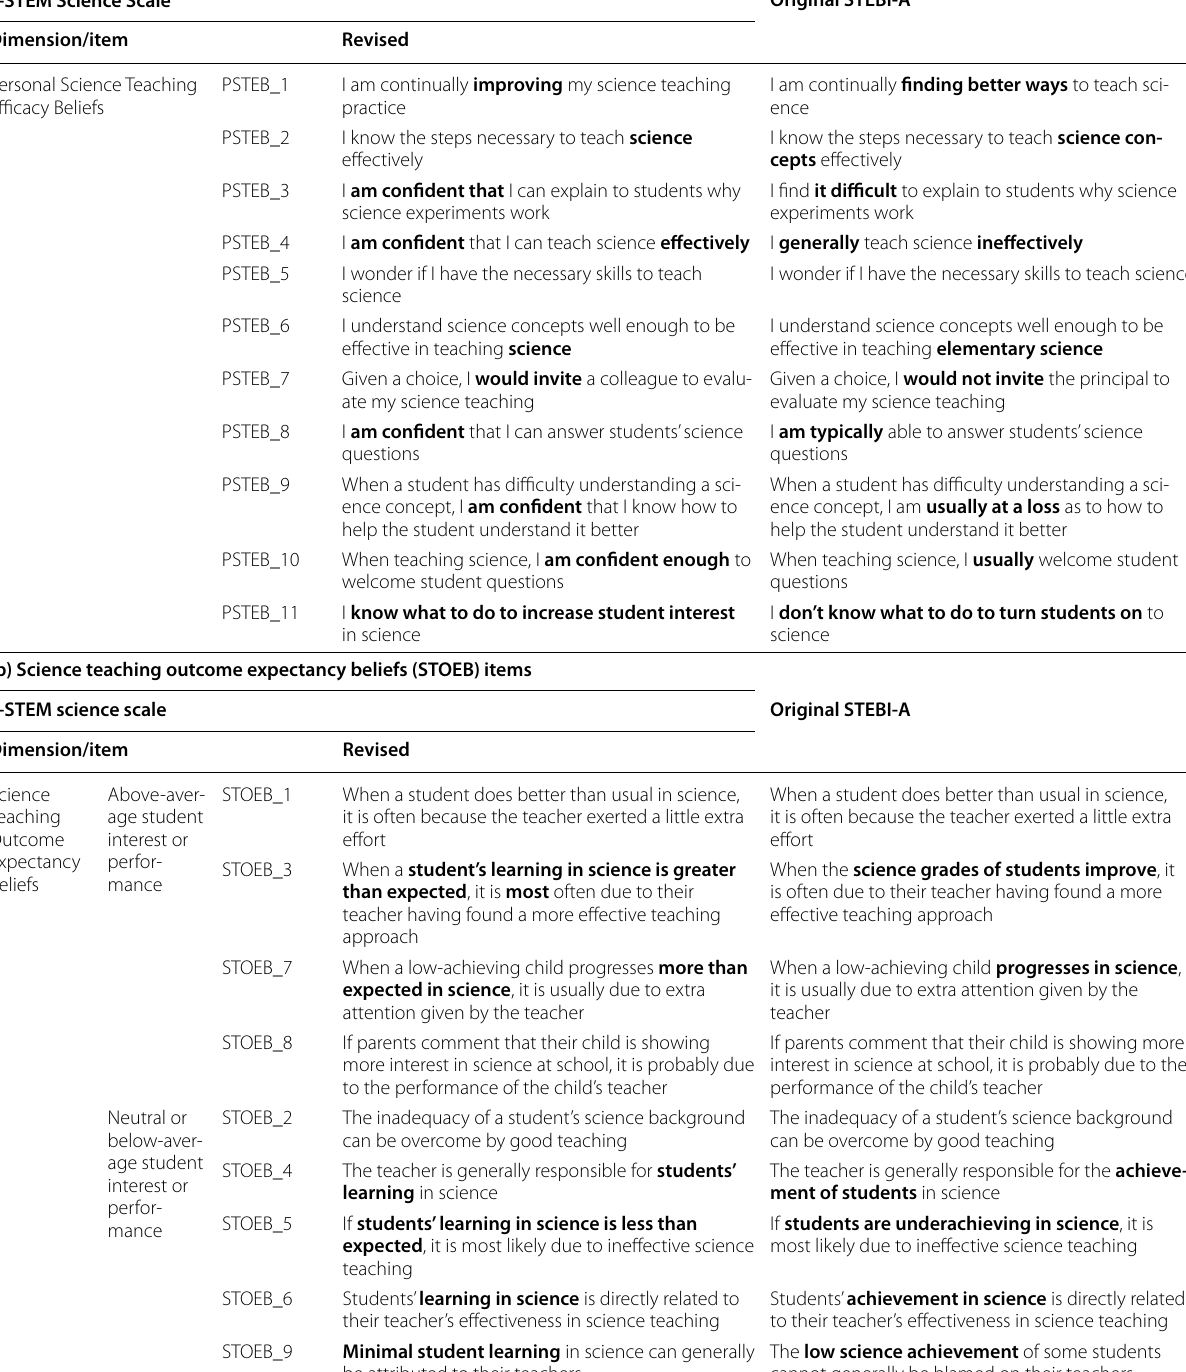
Table 1 T-STEM Science survey items and their original STEBI-A wording (a) Personal science teaching efficacy beliefs (PSTEB) Items T‑STEM Science Scale Original STEBI‑A Dimension/item Revised Personal Science Teaching Efficacy